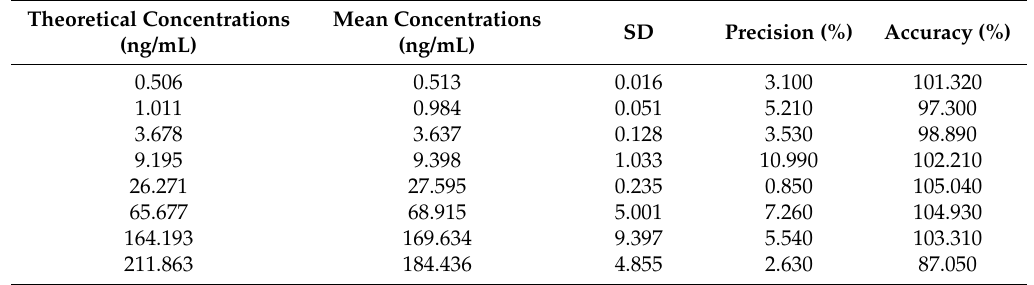
Figure 2. LC ‐ MS/MS chromatogram of diosmetin from plasma sample of a treated volunteer.